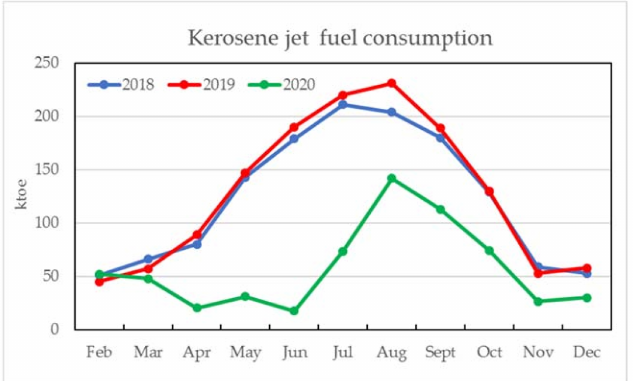
Figure 11. Inland consumption of kerosene jet fuel (in ktoe) for the years 2018, 2019, and 2020 (2020 provisional